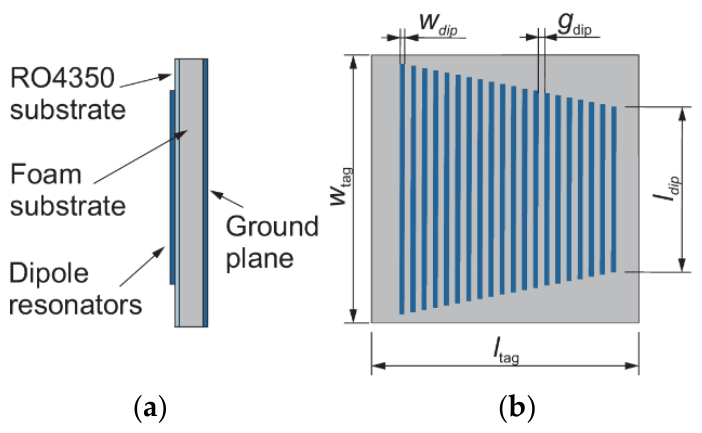
Figure 8. Cross-section ( a ) and top view ( b ) of the detuned dipoles array placed above a metallic plate chipless RFID tag.